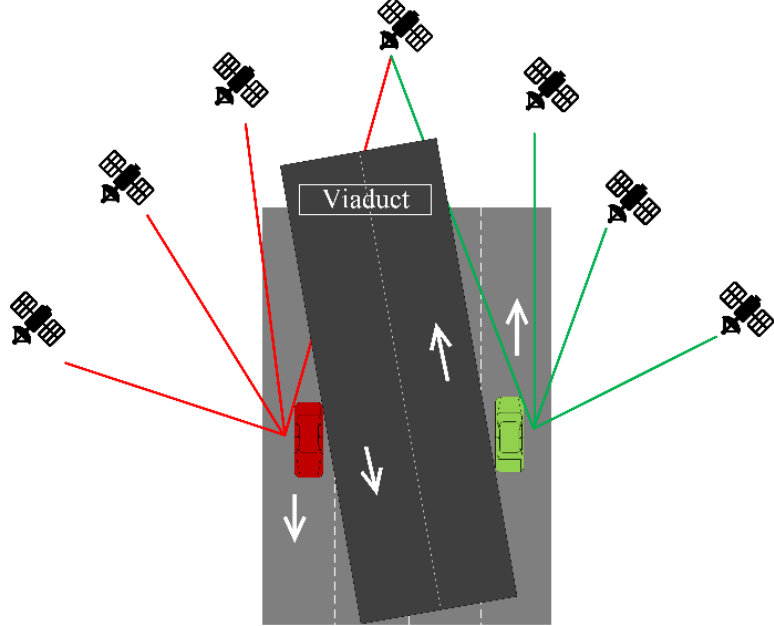
Figure 1. Illustration of two vehicles moving below a viaduct and Global Navigation Satellite System (GNSS) satellites positioning.